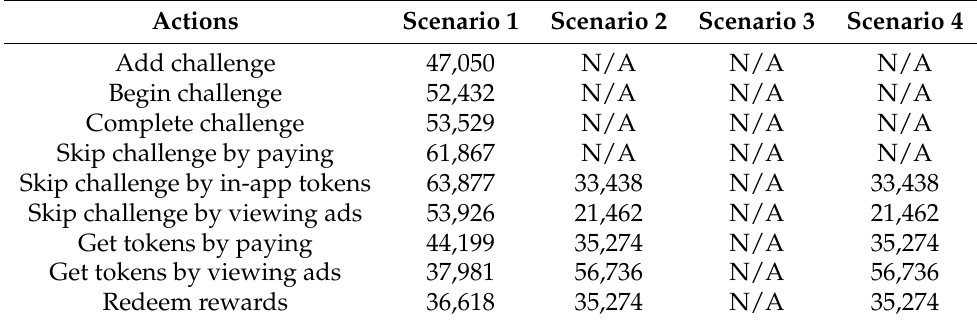
Table 2. Ethereum virtual machine execution cost